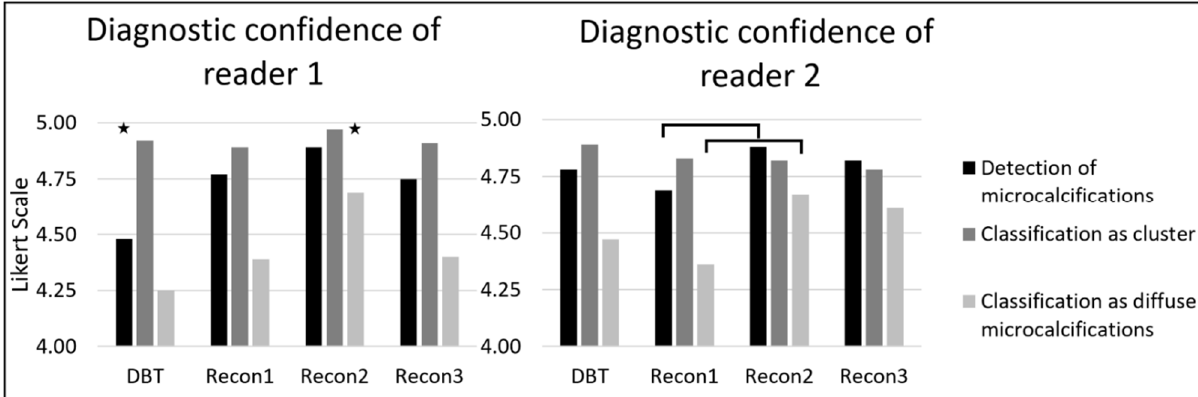
Figure 4. The diagnostic confidence of readers 1 and 2 on a 5-point Likert scale. Comparison of digital breast tomosynthesis (DBT) and three different reconstructions of the dedicated spiral breast computed tomography (SBCT; Recon1 = voxel size of (0.15 mm) 3 , smooth kernel; Recon2: voxel size of (0.05 mm) 3 , smooth kernel; Recon3: voxel size of (0.05 mm) 3 , sharp kernel). Diagnostic confidence for the detection of microcalcifications was best for Recon2. Diagnostic confidence for the classification as a cluster was equal in all groups. Diffuse microcalcifications were easiest classified with SBCT, especially with Recon2. Significant differences ( p < 0.05) between two groups are marked with a line. The differences between one group (star) and the other three groups are also marked.